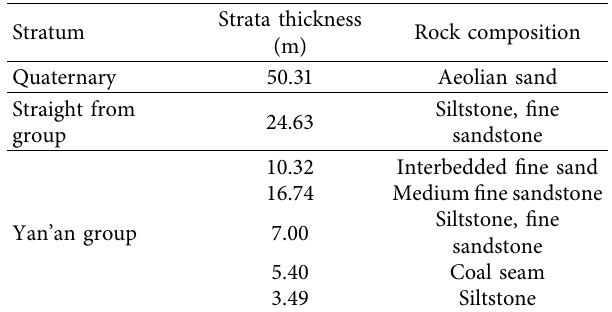
Table 1: Characteristics of borehole rock strata at the sand breaking point of Halagou